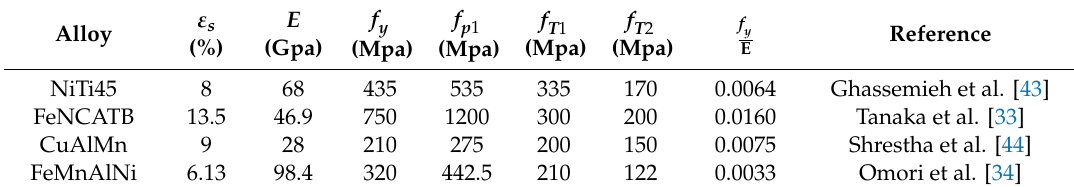
Table 1. Properties of di ff erent types of Shape Memory Alloys